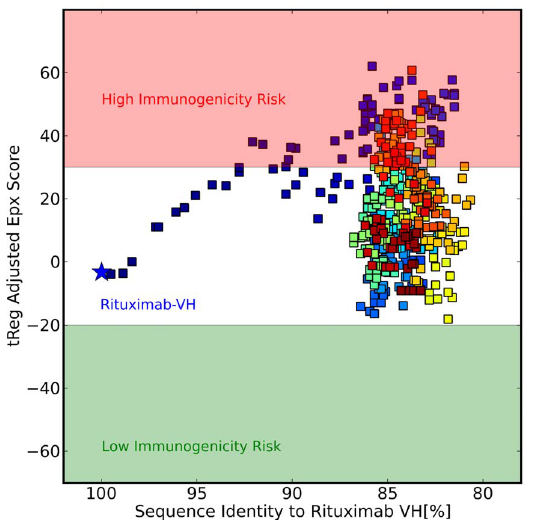
Figure 6. Couplings are required to generate non-immuno- genic sequences. The plot shows the development of the Epivax score over the course of a Monte Carlo optimization of Rituximab-VH. The scoring function used here does not consider couplings of sequence positions and as a consequence, no sequences with low immunogenic potential are sampled.